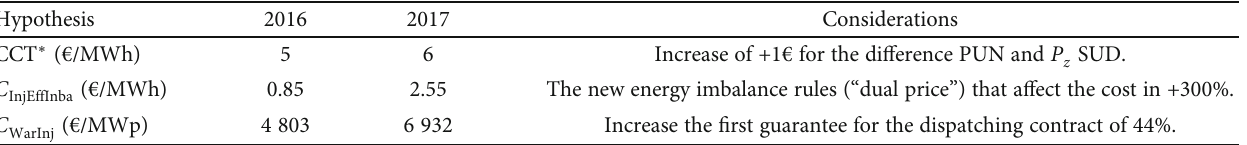
Table 1: Main changes 2016 vs. 2017.